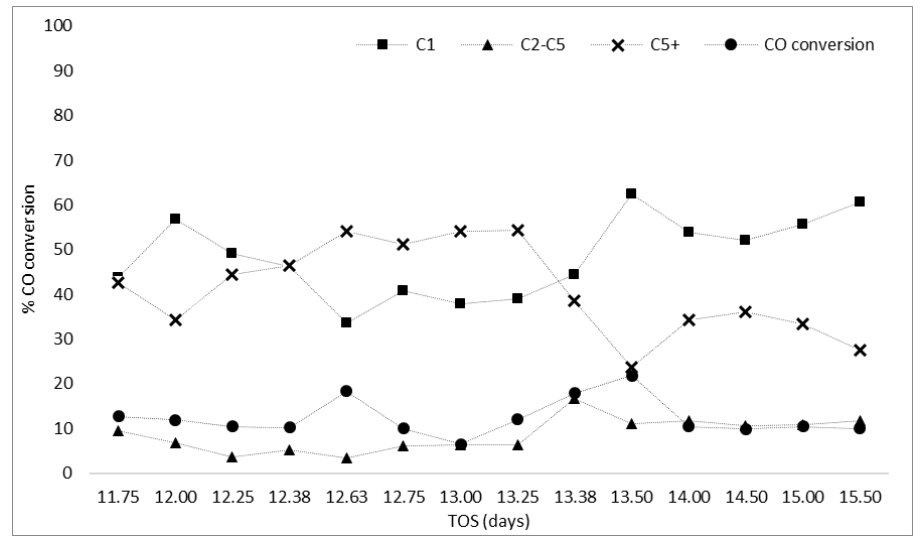
Figure 8. Conversion for Zones A, B, and C in R4 (refer to Tables 3 and 4 for reaction details).